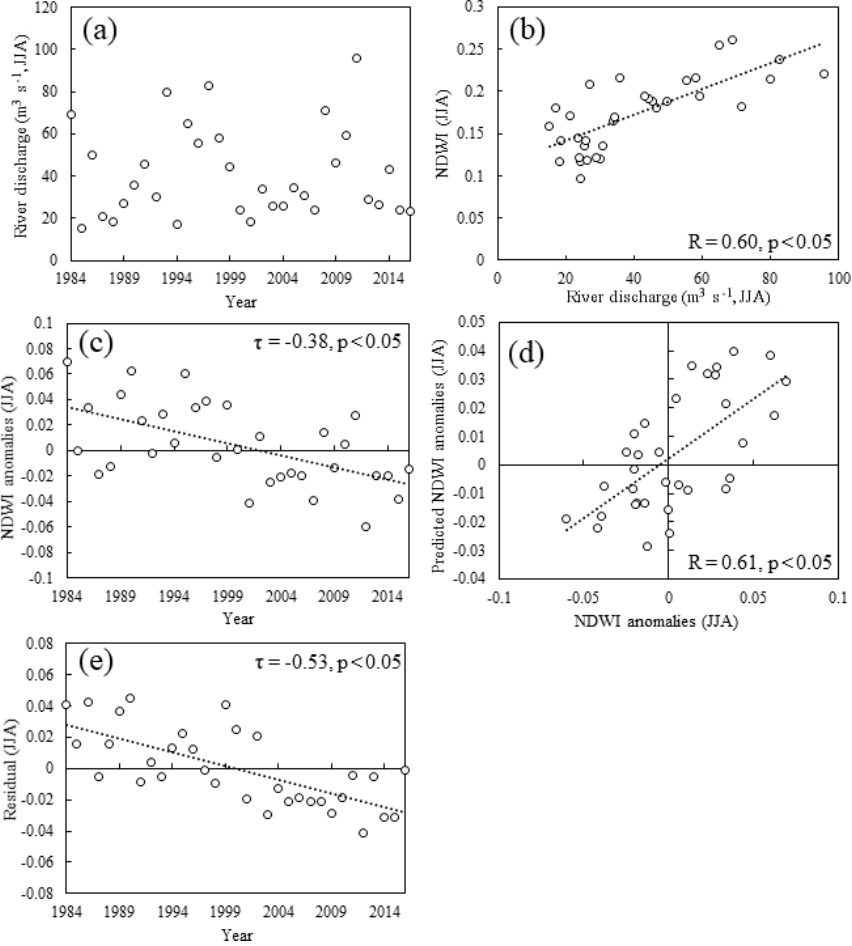
Figure 6. Statistics for the Gallatin River riparian reach downstream of the East Gallatin River (GR1), including (a) variability in river discharge over time (station ID: 6052500), (b) relationship between the normalized difference wetness index (NDWI) and river discharge, (c) trend in NDWI anomalies over time, (d) correlation between NDWI anomalies and predicted NDWI anomalies, and (e) trend in NDWI anomaly–climate regression residuals over